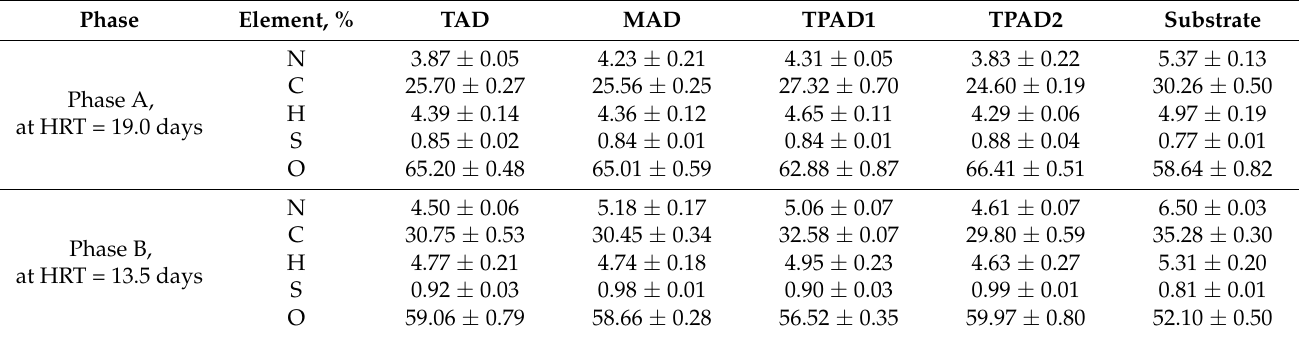
Table 8. The elemental composition of digested sludge (average values).